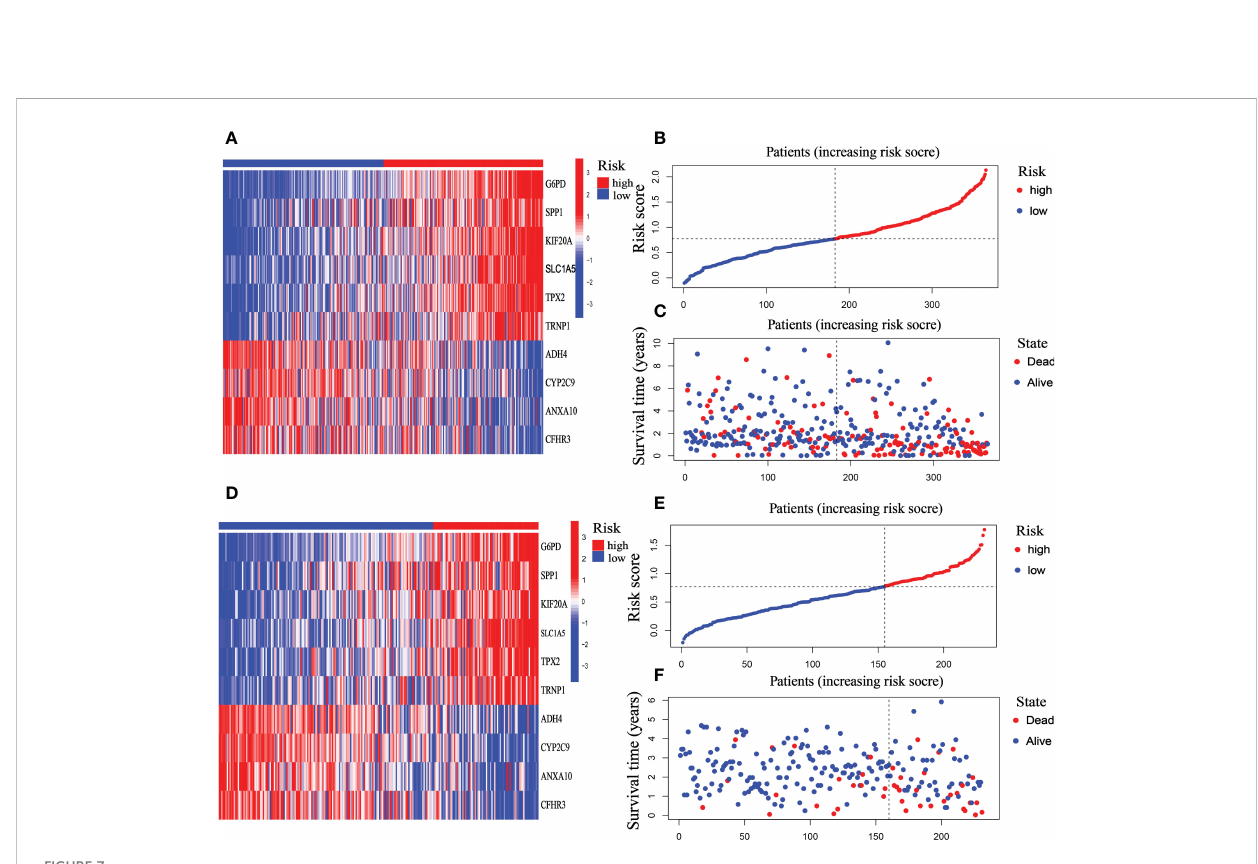
FIGURE 7 Prognostic characteristic of the ten-gene signature model in the TCGA and ICGC cohort. (A) The expression pro fi le heatmap of ten mitophagy- related genes in TCGA dataset. (B) riskScore distribution in TCGA dataset. (C) Survival status heatmap in TCGA dataset. (D) The expression pro fi le heatmap of ten mitophagy-related genes in ICGC dataset. (E) riskScore distribution in ICGC dataset. (F) Survival status heatmap in ICGC